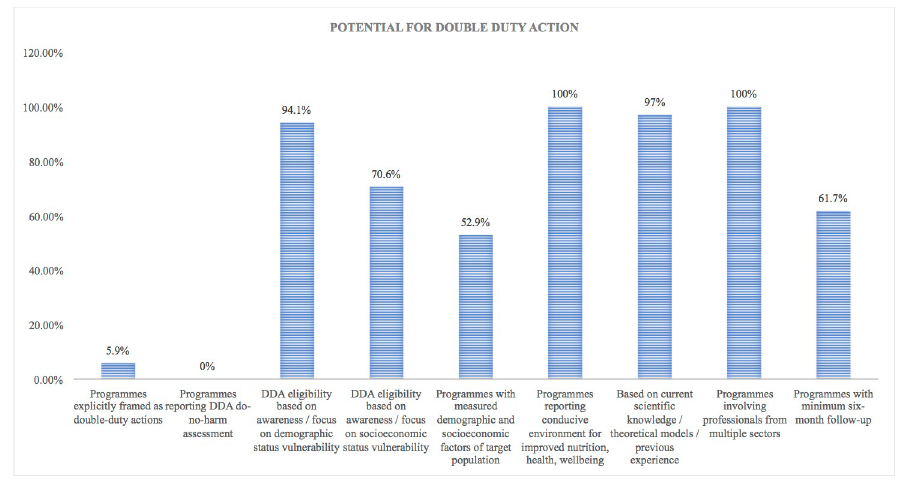
Fig 5. Potential for double duty